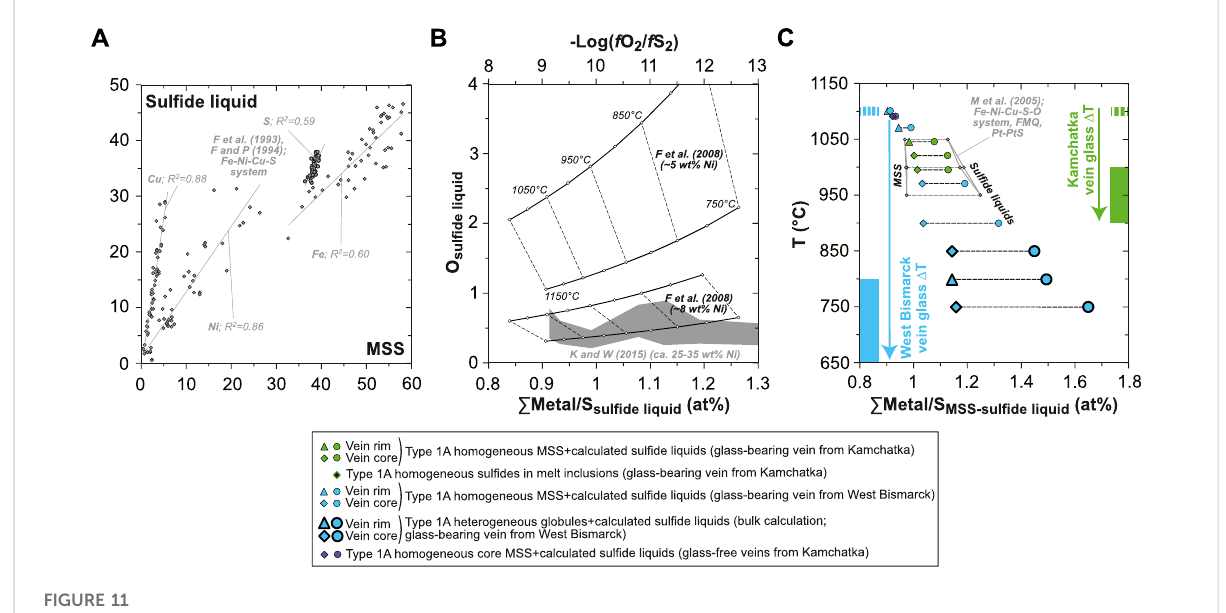
FIGURE 11 Estimates of the compositions of the parental sul fi de liquids in Kamchatka and West Bismarck Type 1A veins (SEM). (A) Relationships between metal (Fe, Ni and Cu) and S abundances in sul fi de liquid and MSS for the experimental results of Fleet and Pan (1994) in the Fe-Ni-Cu-S system (gray dots;allinwt%). (B) Relationships betweenOabundances(wt%)insul fi deliquidsandtheir (cid:1) Metal/S (at%)or − log( f O 2 / f S 2 ).Results usingthesolubility model of O in sul fi de liquids from Fonseca et al. (2008) are plotted against − log( f O 2 / f S 2 ) (black lines with white dots), whereas those using the solubility model of O in sul fi de liquids from Kiseeva and Wood (2015) are plotted against (cid:1) Metal/S (gray fi eld). Both models give consistent O solubilities(ca.0.5to2 wt%)asNicontentsincreasefrom~5to~8 wt%andaboveinsul fi deliquids,whichisthecaseforthosederivedfromLCB(see text for details). (C) Relationships between temperature and (cid:1) Metal/S (at%) for MSS (diamonds) and their parental sul fi de liquid estimates (dots) in Kamchatka and West Bismarck veins. Also shown are the variable undercooling degrees ( Δ T) experienced by the glass-forming melt in veins